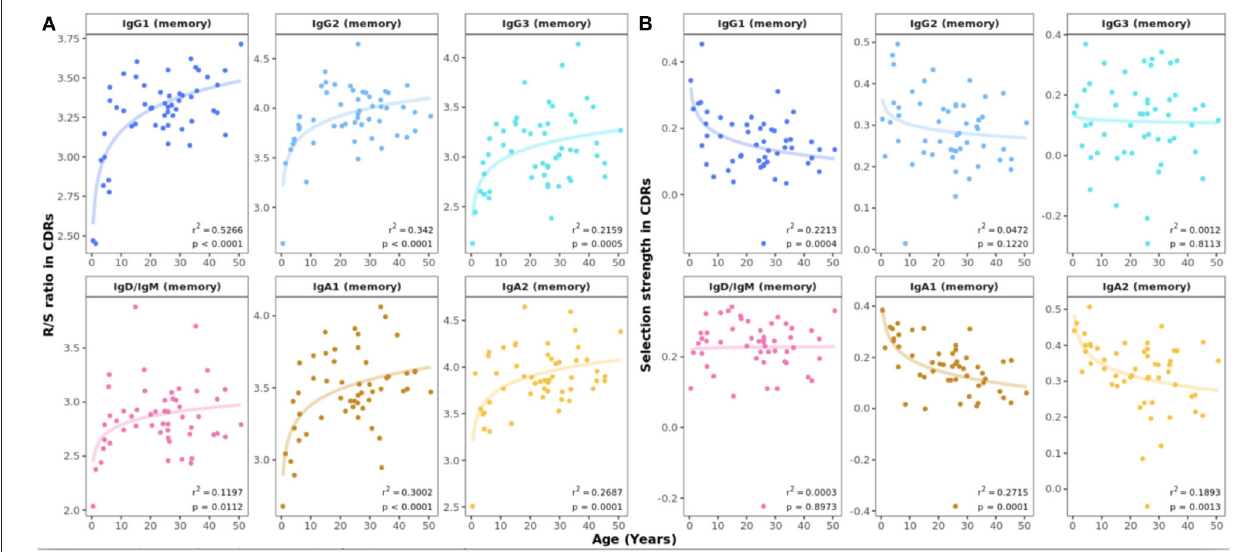
FIGURE 5 | Age-related changes in antigen-driven selection. (A) Mean R/S ratio in V gene CDRs as a measure of selection pressure showed an increase in early childhood in all mutated B cell subsets. For sequences with replacement but no silent mutations, the number of silent mutations was set to 1. (B) Mean selection strength in CDRs calculated using BASELINe decreases with age in class switched